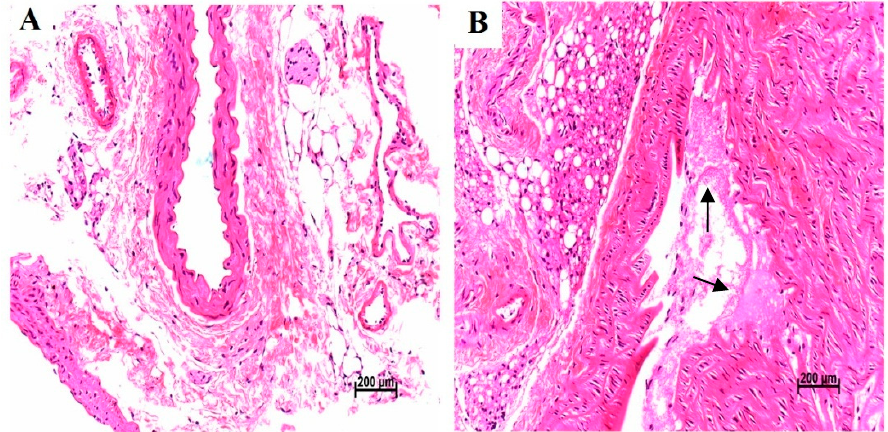
Figure 8. Coronary artery histological evaluation and pathological scores in mice after exposed to fine particles. ( A ) represents normal vessel tissue in C57BL/6 mice; ( B ) black arrows represent plague formation in ApoE − / − mice. Histological lesions (×200) of coronary arteries in mice.